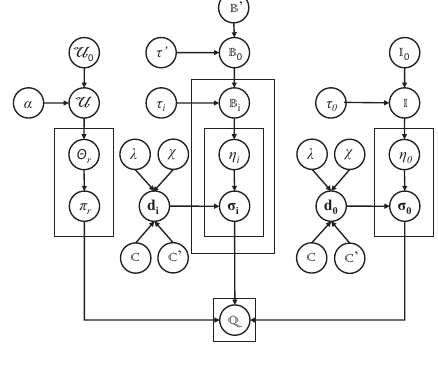
Figure 2. The FPIM has